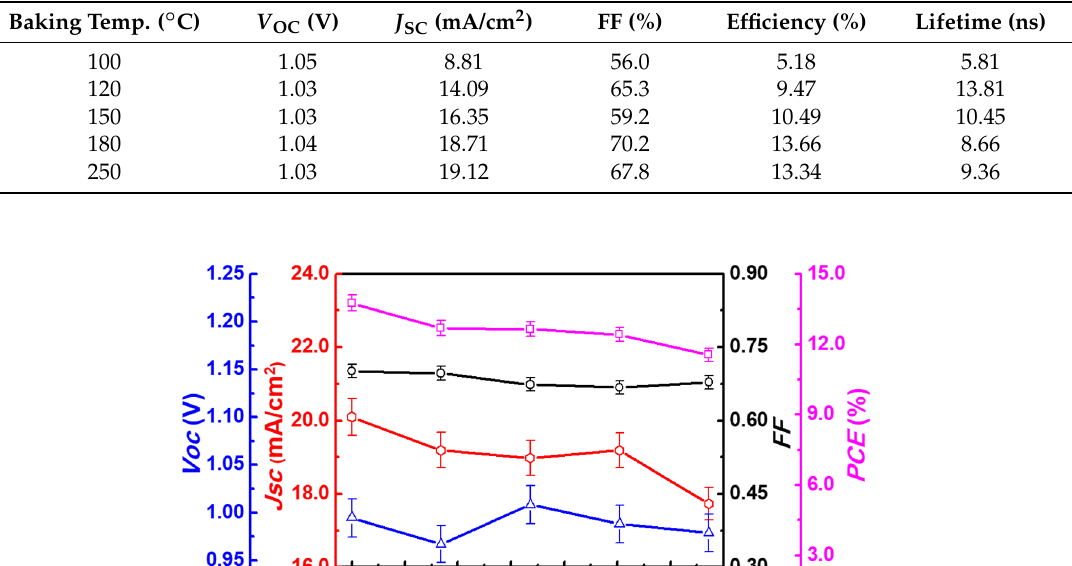
Figure 8. Stability of the ZnO ‐ based perovskite photovoltaic device stored in a dark condition (5.0% RH and 25 °C).